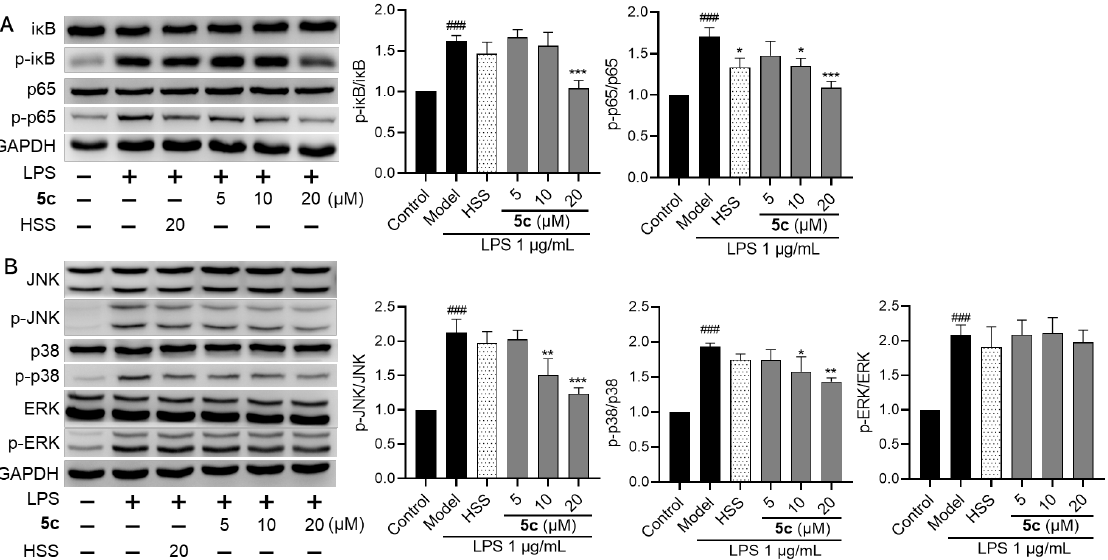
Figure 6. The impact of compound 5c on LPS-triggered ( A ) NF- κ B and ( B ) MAPK (JNK, p38, and ERK1/2) activation in RAW264.7 macrophages following a 2 h treatment with a combination of LPS (1 µ g/mL) and 5c or HSS. Data are expressed as the means ± SD ( n = 3) from triplicate experiments. ### p < 0.001 vs. control; * p < 0.05, ** p < 0.01, *** p < 0.001 vs. model.